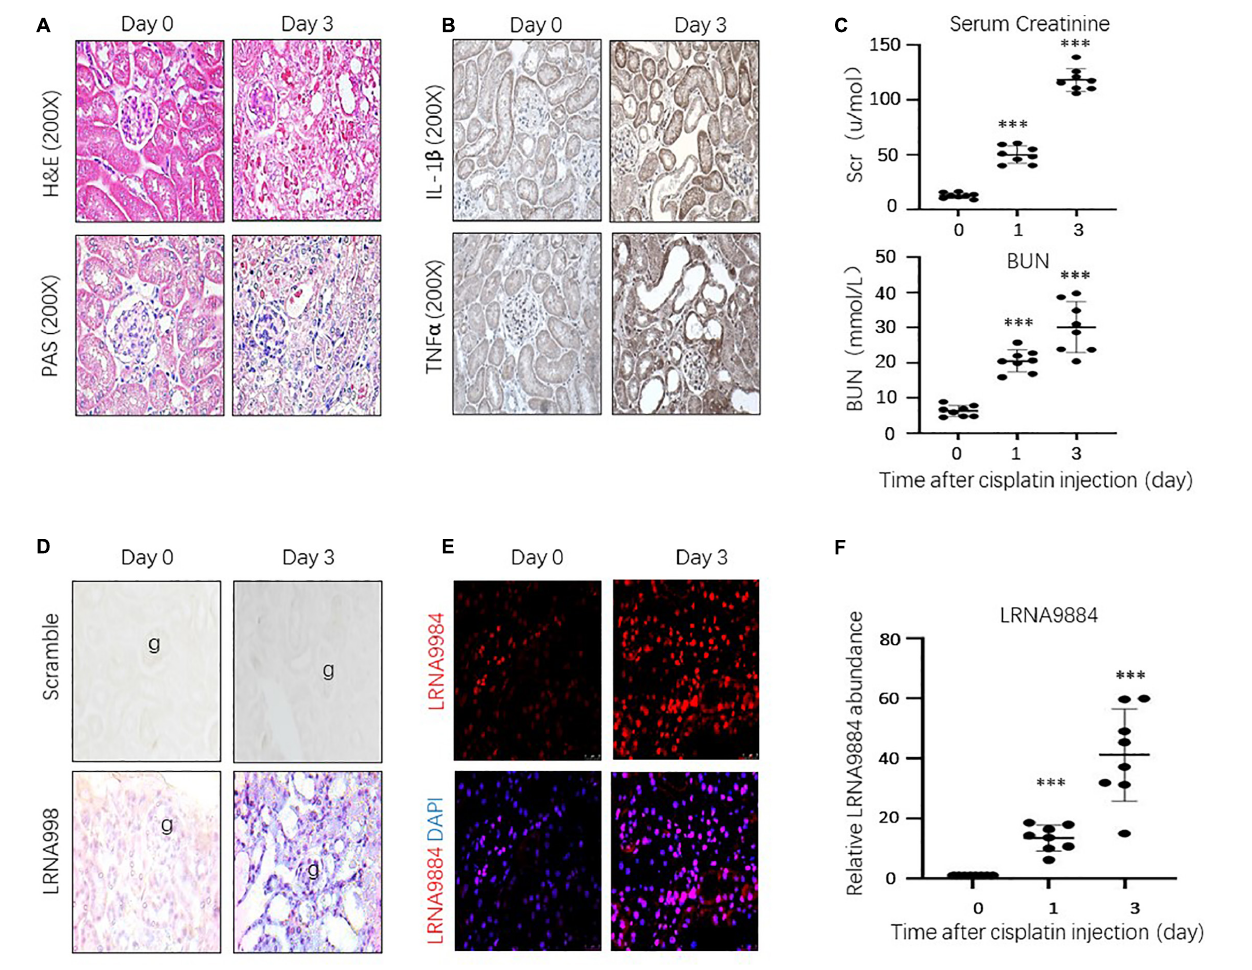
FIGURE 1 | LRNA9884 and inflammatory cytokine expression in mice with cisplatin-induced AKI. (A) H&E staining and PAS staining shows changes in renal histology after AKI injury at day 0 and day 3. (B) Immunohistochemistry (IHC) of IL-1 β and TNF- α expression (200 × magnification). (C) Serum creatinine and blood urea nitrogen (BUN) of AKI mice. (D,E) ISH and FISH detects LRNA9884 expression at day 0, and day 3 after AKI injury (200 × magnification). (F) Real-time PCR shows expression of LRNA9884 in mice kidneys. Bar represents the mean ± SEM for groups of eight mice. *** P < 0.001 vs. mice at day 0.